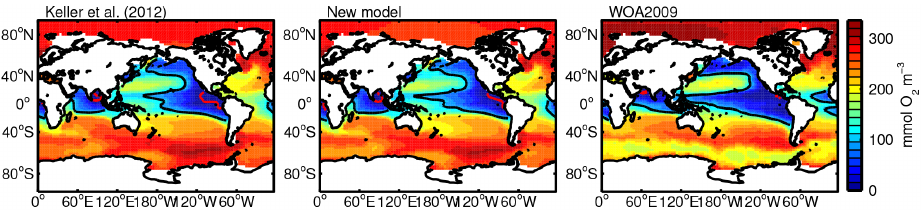
Figure 10. Annual mean oxygen concentrations at 450m depth for the model by Keller et al. (2012) and the new model in comparison to observations from the World Ocean Atlas 2009 (WOA, 2009) (Garcia et al., 2010a). The black contour line is located at concentrations of 100mmolO 2 m − 3 , the red contour line is located at concentrations of 5mmolO 2 m − 3